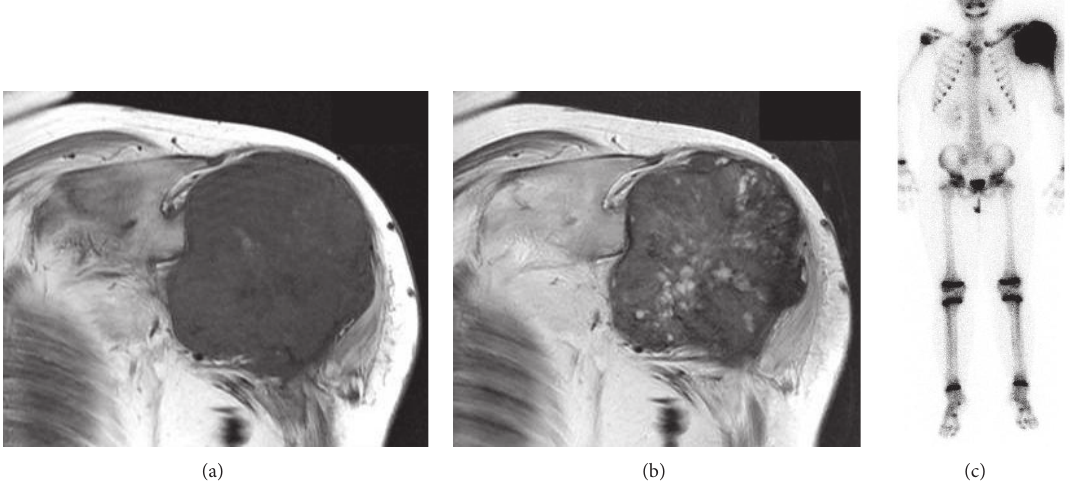
Figure 2: Coronal T1-weighted (a) and T2-weighted (b) MR images demonstrated a huge tumor in the proximal humerus. Whole body technetium-99m scan showed abnormal uptake in the left proximal humerus and surrounding area